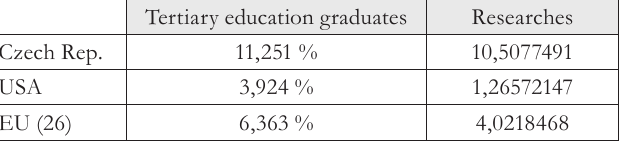
Tab. 8 - Geometric average annual growth rates for the period 2000 – 2009. Source: Source: (Eurostat, 2013a), (Eurostat, 2013b), own